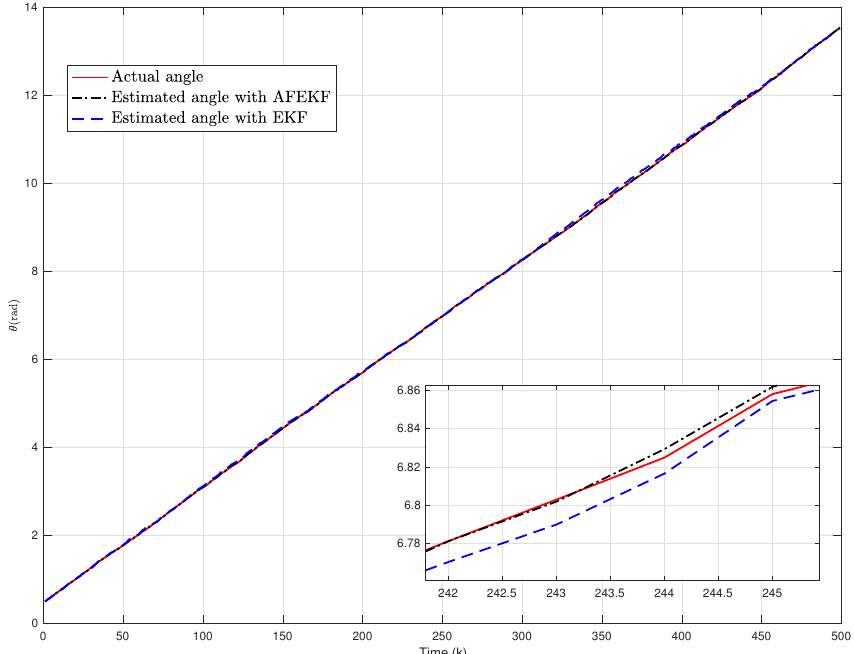
Figure 7. Robot’s angle and its estimates under stochastic bias.